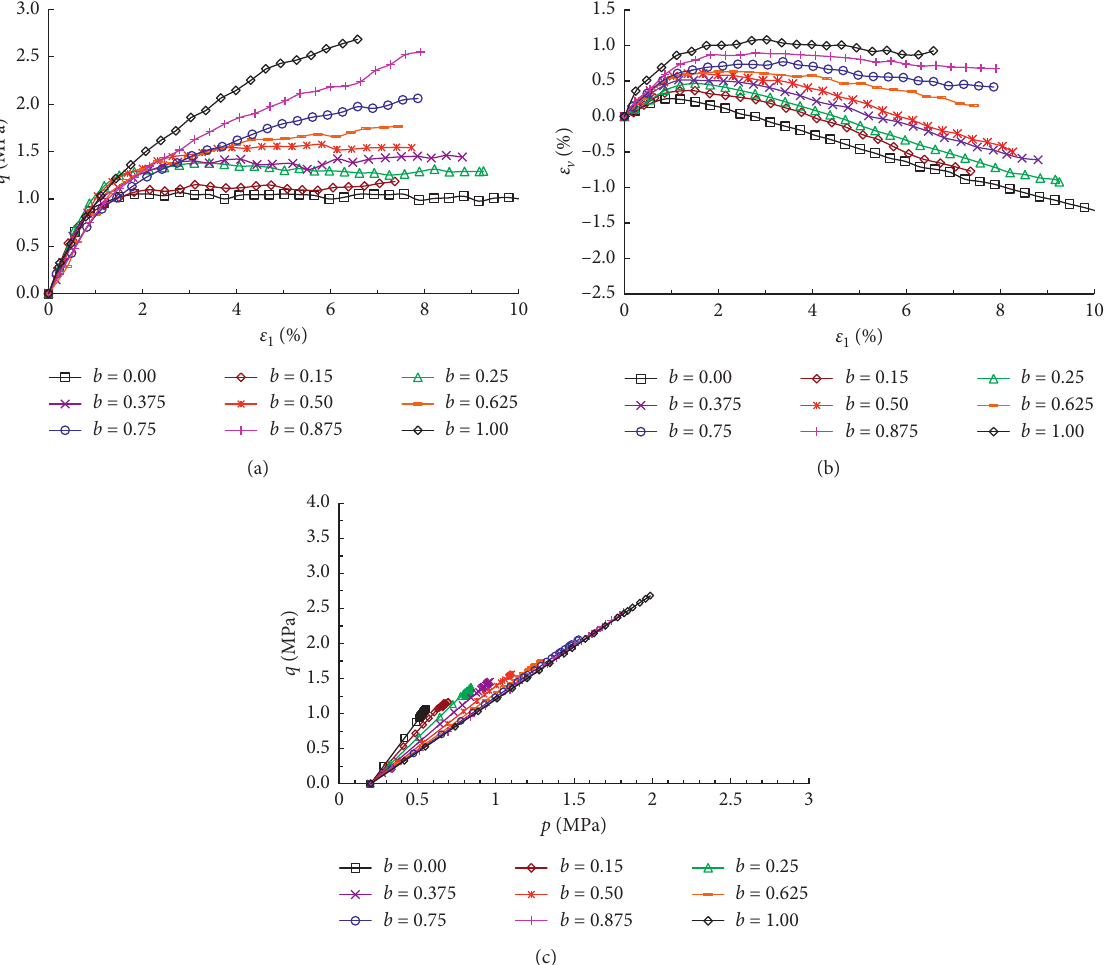
Figure 8: The results of the constant σ